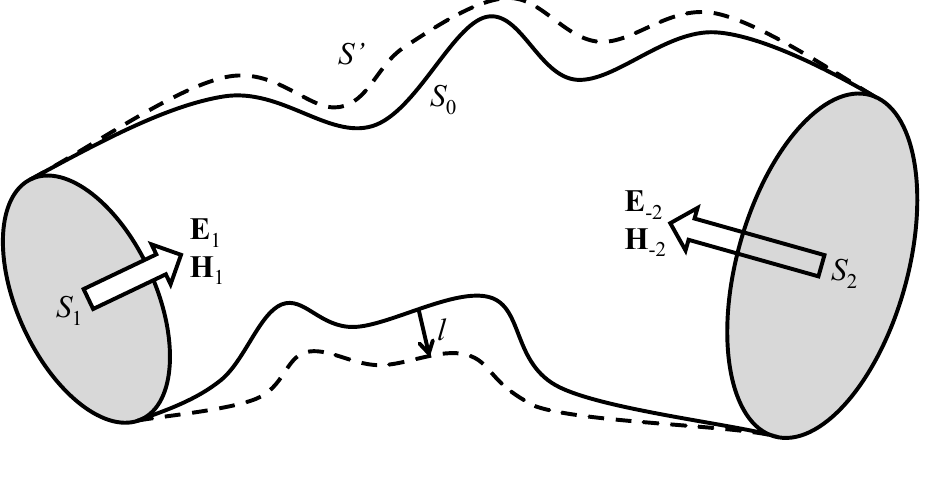
Fig. 2. Notations used in iterative synthesis